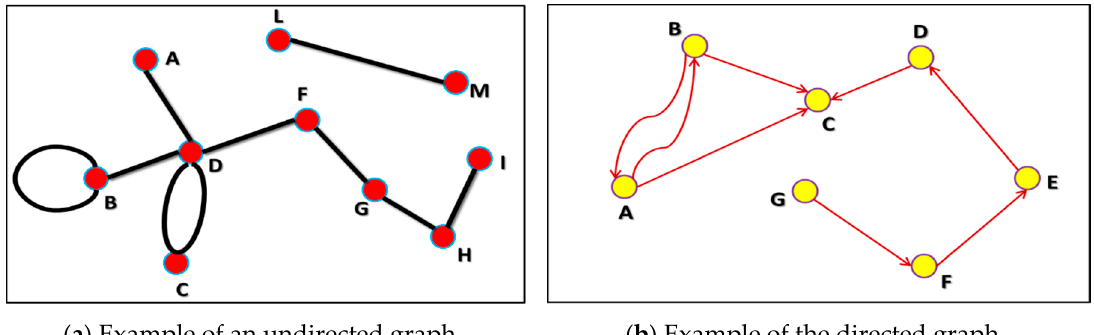
Figure 2. Pictorial overview of the directed and undirected graphs.